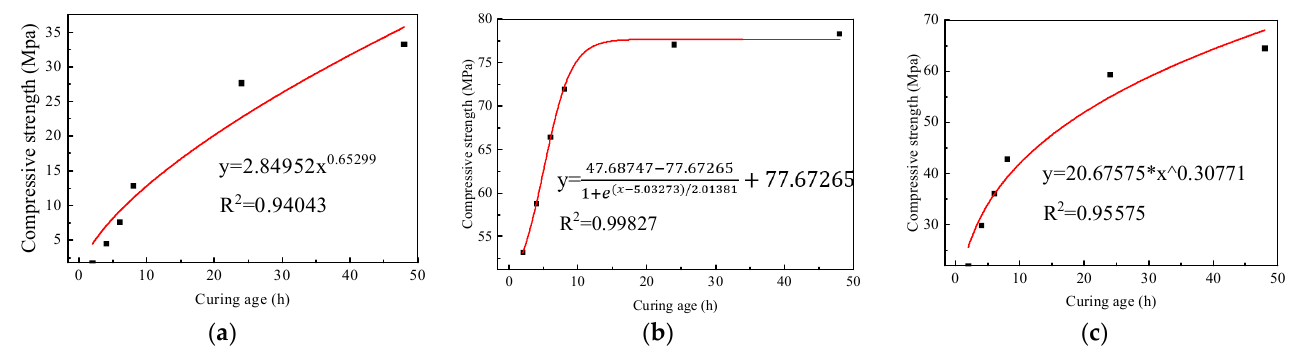
Figure 3. Fitting results of the strength of alkali-activated mortars under steam curing at 80 °C: ( a ) FZ80; ( b ) GZ80; ( c )